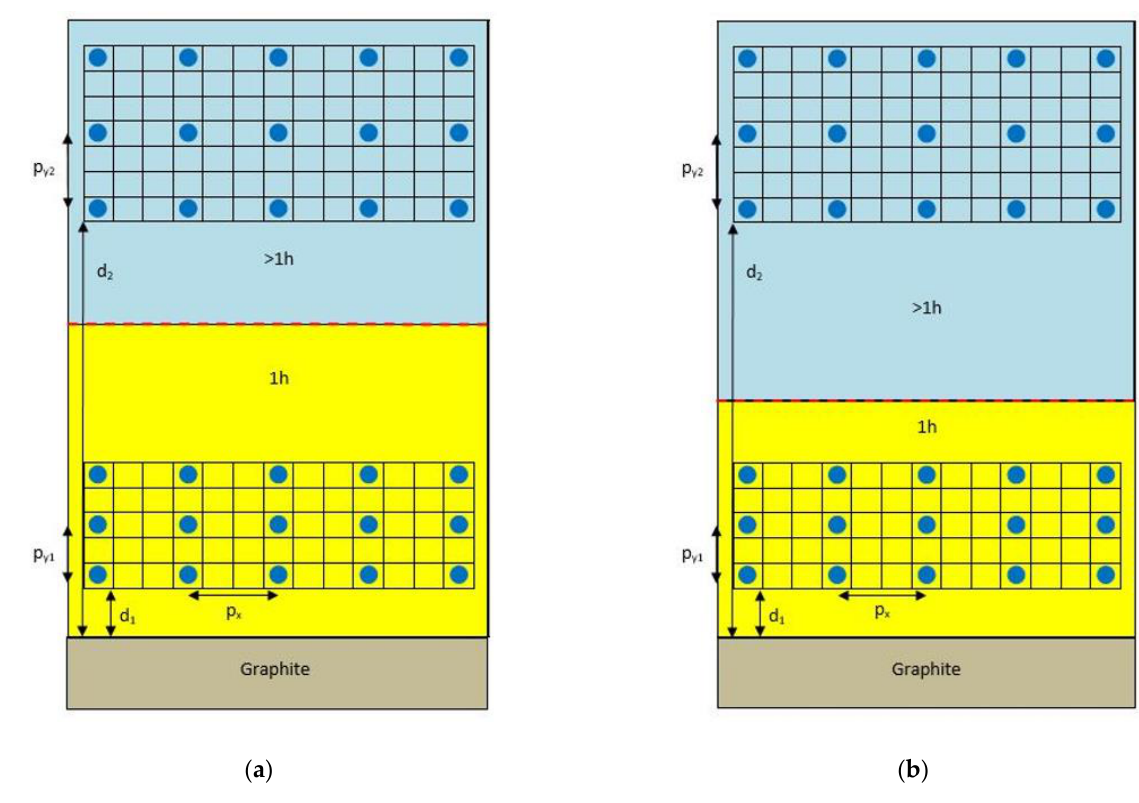
Figure 3. Schematization of the indentation points: ( a ) on the pyrolytic carbon (PyC) deposited through the historical process; ( b ) on the PyC deposited through the modified process. In yellow, the inner layers (deposited during the first hour of the process) in light blue, the outer layers (deposited after one hour the beginning of the process). d 1 is the distance between the graphite substrate interface and the first indentation equal to 20 µm. d 2 is the distance between the graphite substrate interface and the indentation sites on the outer layers equal to 250 µm. p x is the distance between indentations along the matrix raw equal to 24 µm. p y1 is the distance between two consecutive indentations on the inner layers equal to 12 µm. p y2 is the distance between two consecutive indentations on the outer layers equal to 24 µm.